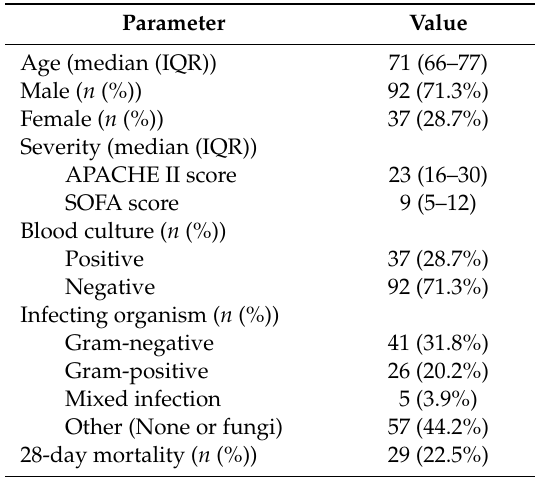
Table 1. Characteristics of the study